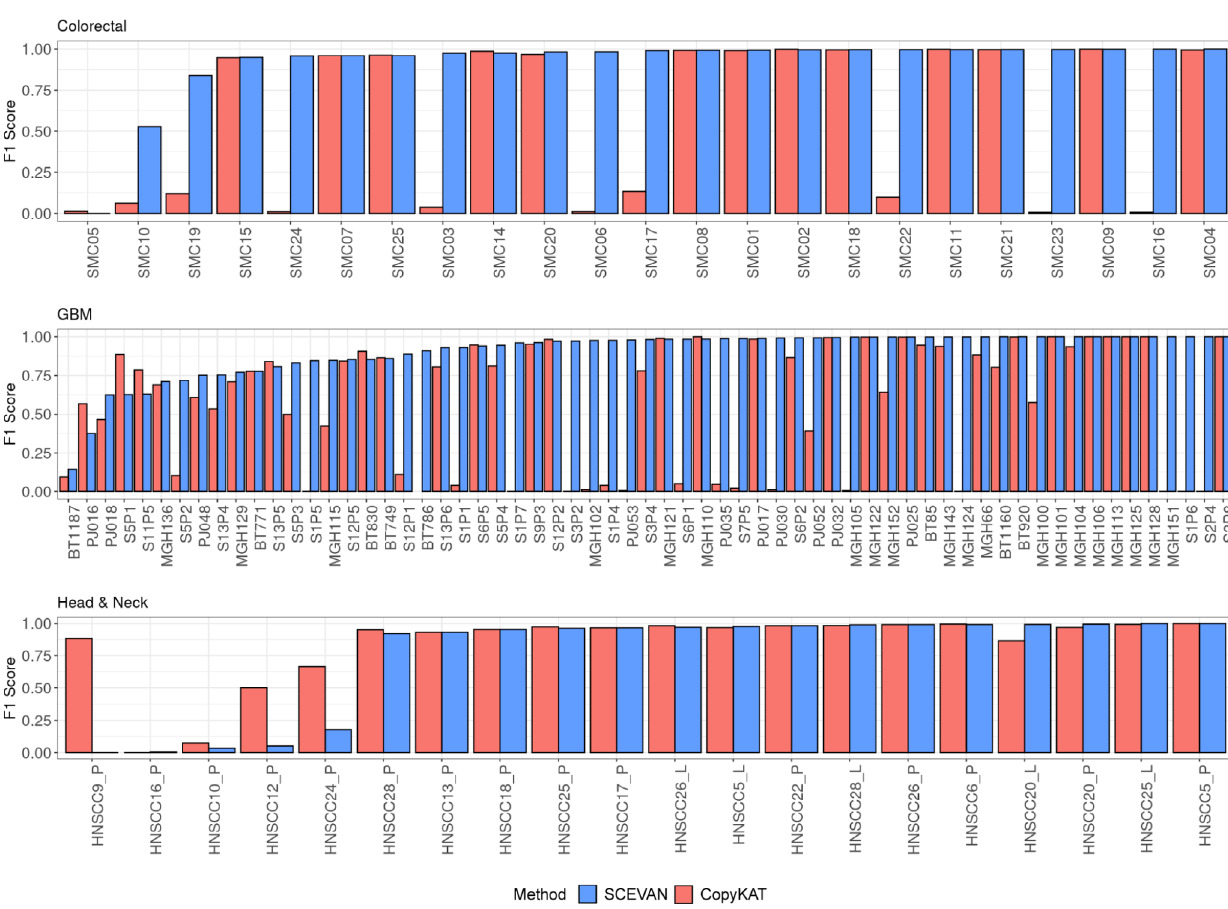
scRNA-seq independent experiments, Headand Neck Squamous Cell Carcinomas 21 n =5717 cells examined over 20 scRNA-seq independent experiments (Supple- mentary Data 2). Source data are provided as a Source Data fi